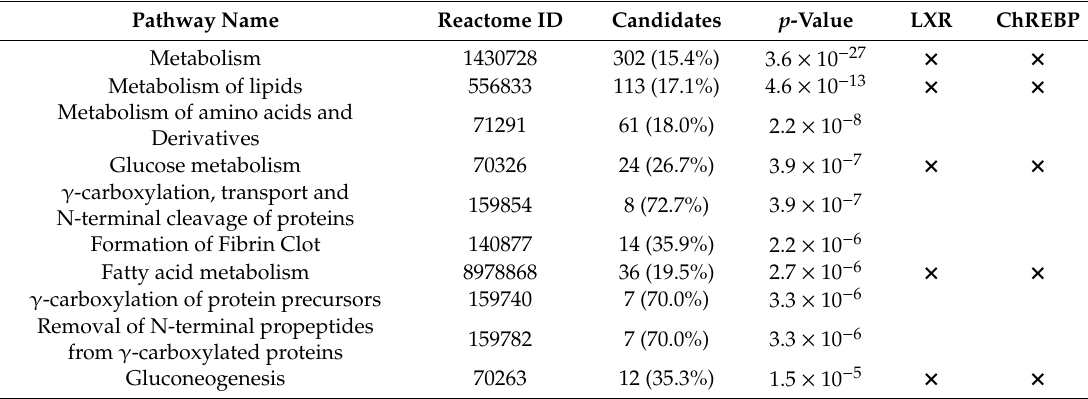
Table 1. Top 10 pathways enriched in genes with ChREBP-LXR peak